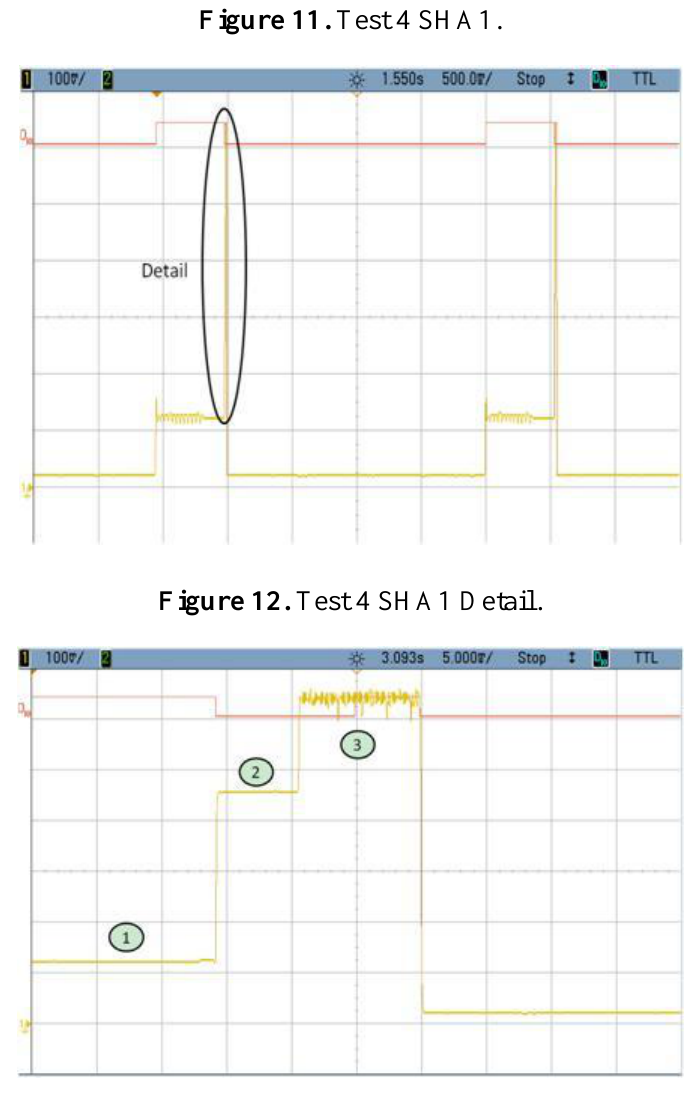
Figure 11. Test 4 SHA1.